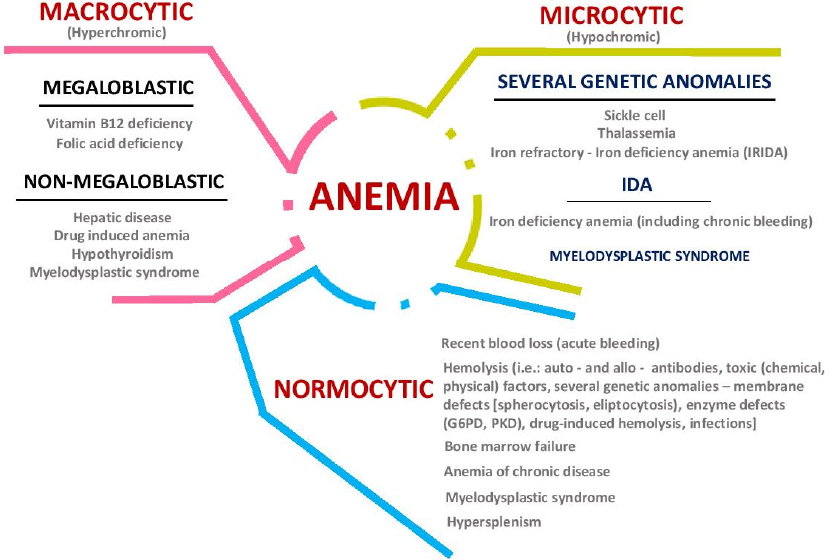
Figure 2. Anemia classification (adapted from [20,32]) (G6PD: Glucose-6-Phosphate-Dehydrogenase; PKD: Pyruvate Kinase Deficiency).